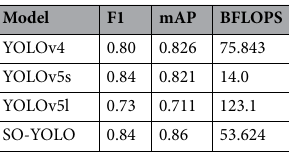
Table 3. Comparison of detection accuracy between SO-YOLO and YOLOv4, YOLOv5s, YOLOv5l.